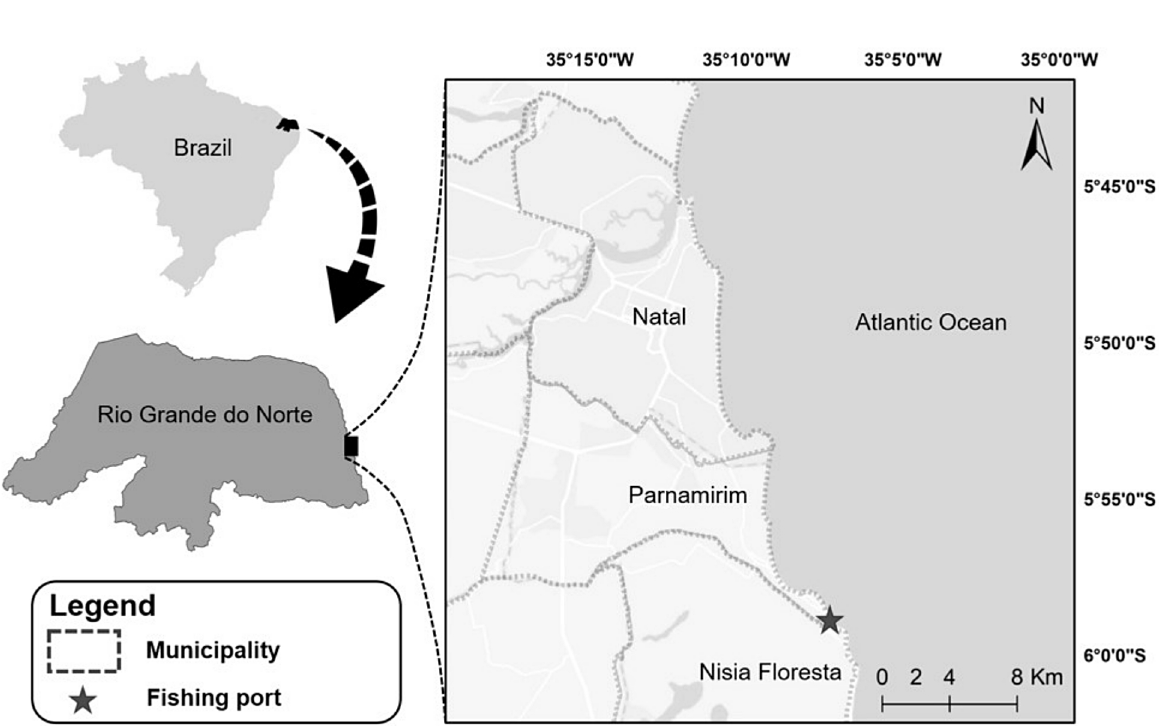
Figure 1. Study area and sampling site of lobster Panulirus spp . on the eastern coast of Rio Grande do